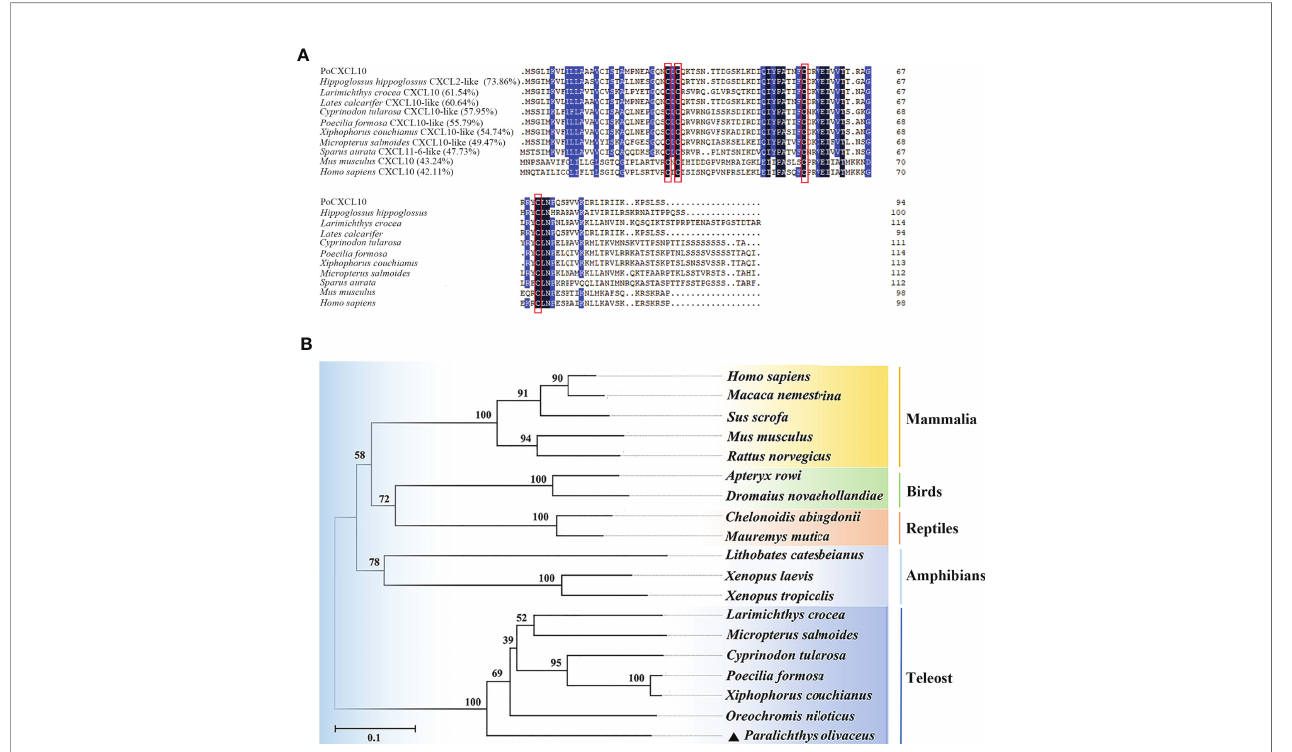
FIGURE 1 | Sequence and phylogenetic analyses of PoCXCL10. (A) Sequence alignment of PoCXCL10 homologues. Dots denote gaps introduced for maximum matching. The conserved cysteine residues are boxed in red; the consensus residues are in black; the residues that are ≥ 75% identical among the aligned sequences are in blue. (B) Phylogenetic analysis of PoCXCL10. The phylogenetic tree was constructed using the neighbor-joining (NJ) method of the MEGA 6.0 package. The GeneBank accession numbers of the sequences are as follows: PoCXCL10, XP_019935349.1; Hippoglossus hippoglossus , XP_034453744.1; Larimichthys crocea , XP_019121063.2; Lates calcarifer , XP_018555122.1; Cyprinodon tularosa , XP_038155112.1; Poecilia formosa , XP_007548388.1; Xiphophorus couchianus , XP_027864958.1; Micropterus salmoides , XP_038555155.1; Sparus aurata , XP_030251220.1; Mus musculus , NP_067249.1; Homo sapiens , NP_001556.2; Oreochromis niloticus , XP_019222559.1; Xenopus tropicalis , XP_002940621.2; Xenopus laevis , XP_018098281.1; Lithobates catesbeianus , PIO23185.1; Mauremys mutica , XP_044875629.1; Chelonoidis abingdonii , XP_032623980.1; Dromaius novaehollandiae , XP_025959343.1; Apteryx rowi , XP_025945955.1; Rattus norvegicus , NP_620789.2; Sus scrofa , ABD18444.1; Macaca nemestrina ,